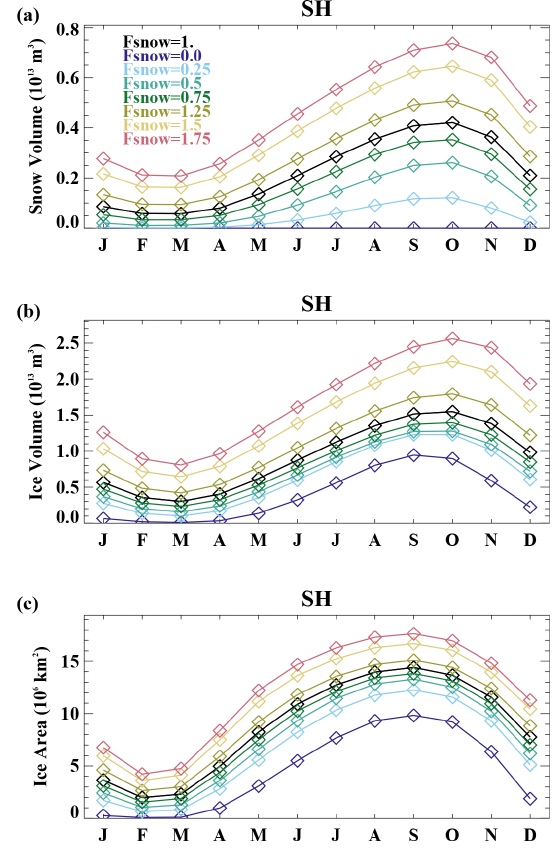
Figure 5. The Southern Hemisphere (a) snow volume, (b) ice vol- ume, and (c) ice area in the different F snow